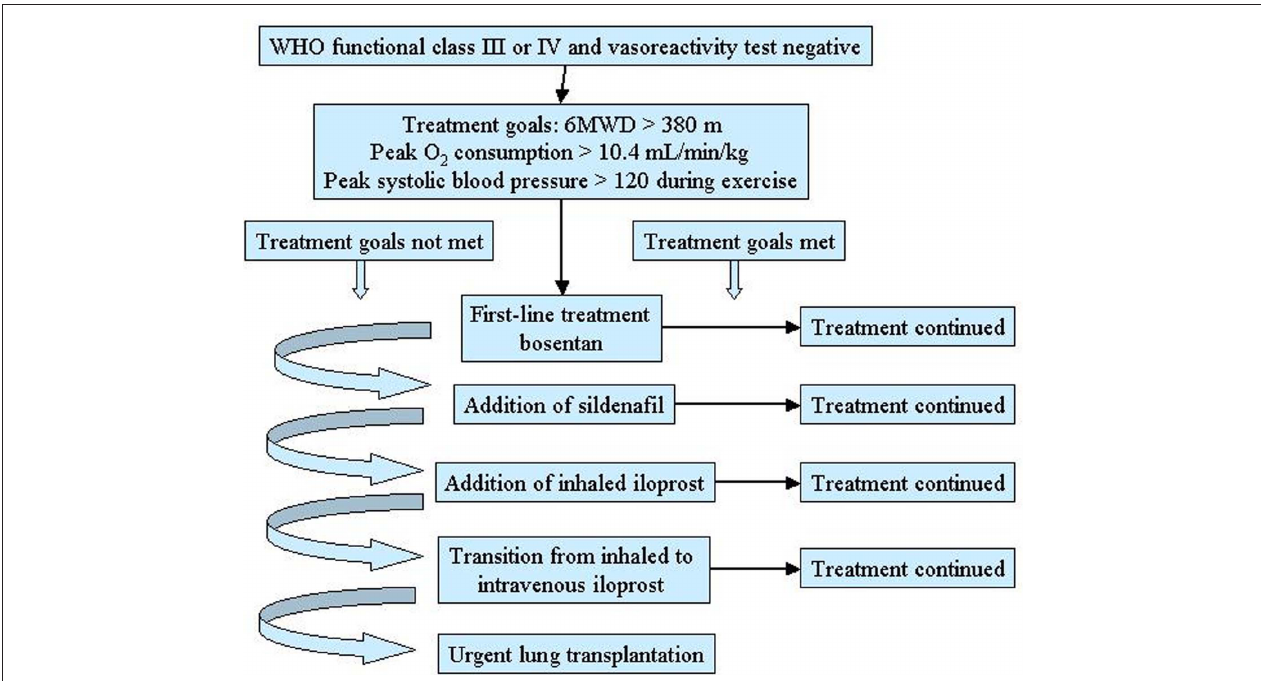
FIGure 3 | Goal-oriented treatment algorithm for patients with pulmonary arterial hypertension (PAH). 6MWD, 6-min walking distance. Reproduced with permission from Hoeper et al.